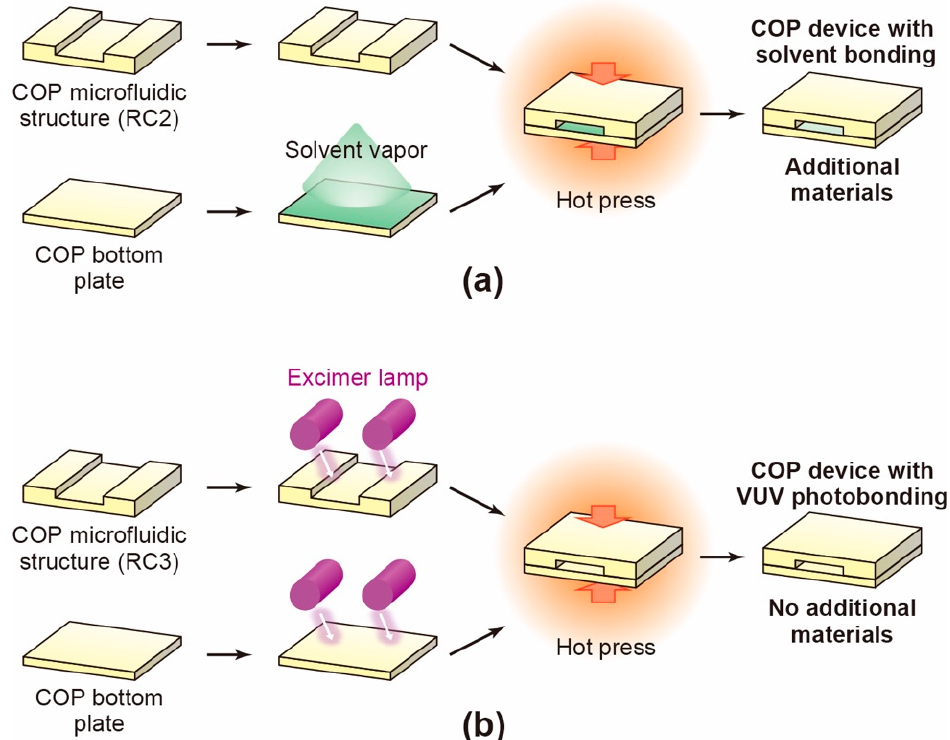
Figure 1. Schematic of the cyclo-olefin polymer (COP)-based microfluidic device fabrication process. Devices were prepared by ( a ) solvent bonding and ( b ) vacuum ultraviolet (VUV) photobonding. A solvent vapor or VUV light from an excimer lamp was used to bond the two components (microfluidic structure and base plate), which were then hot-pressed together to form the microfluidic device.